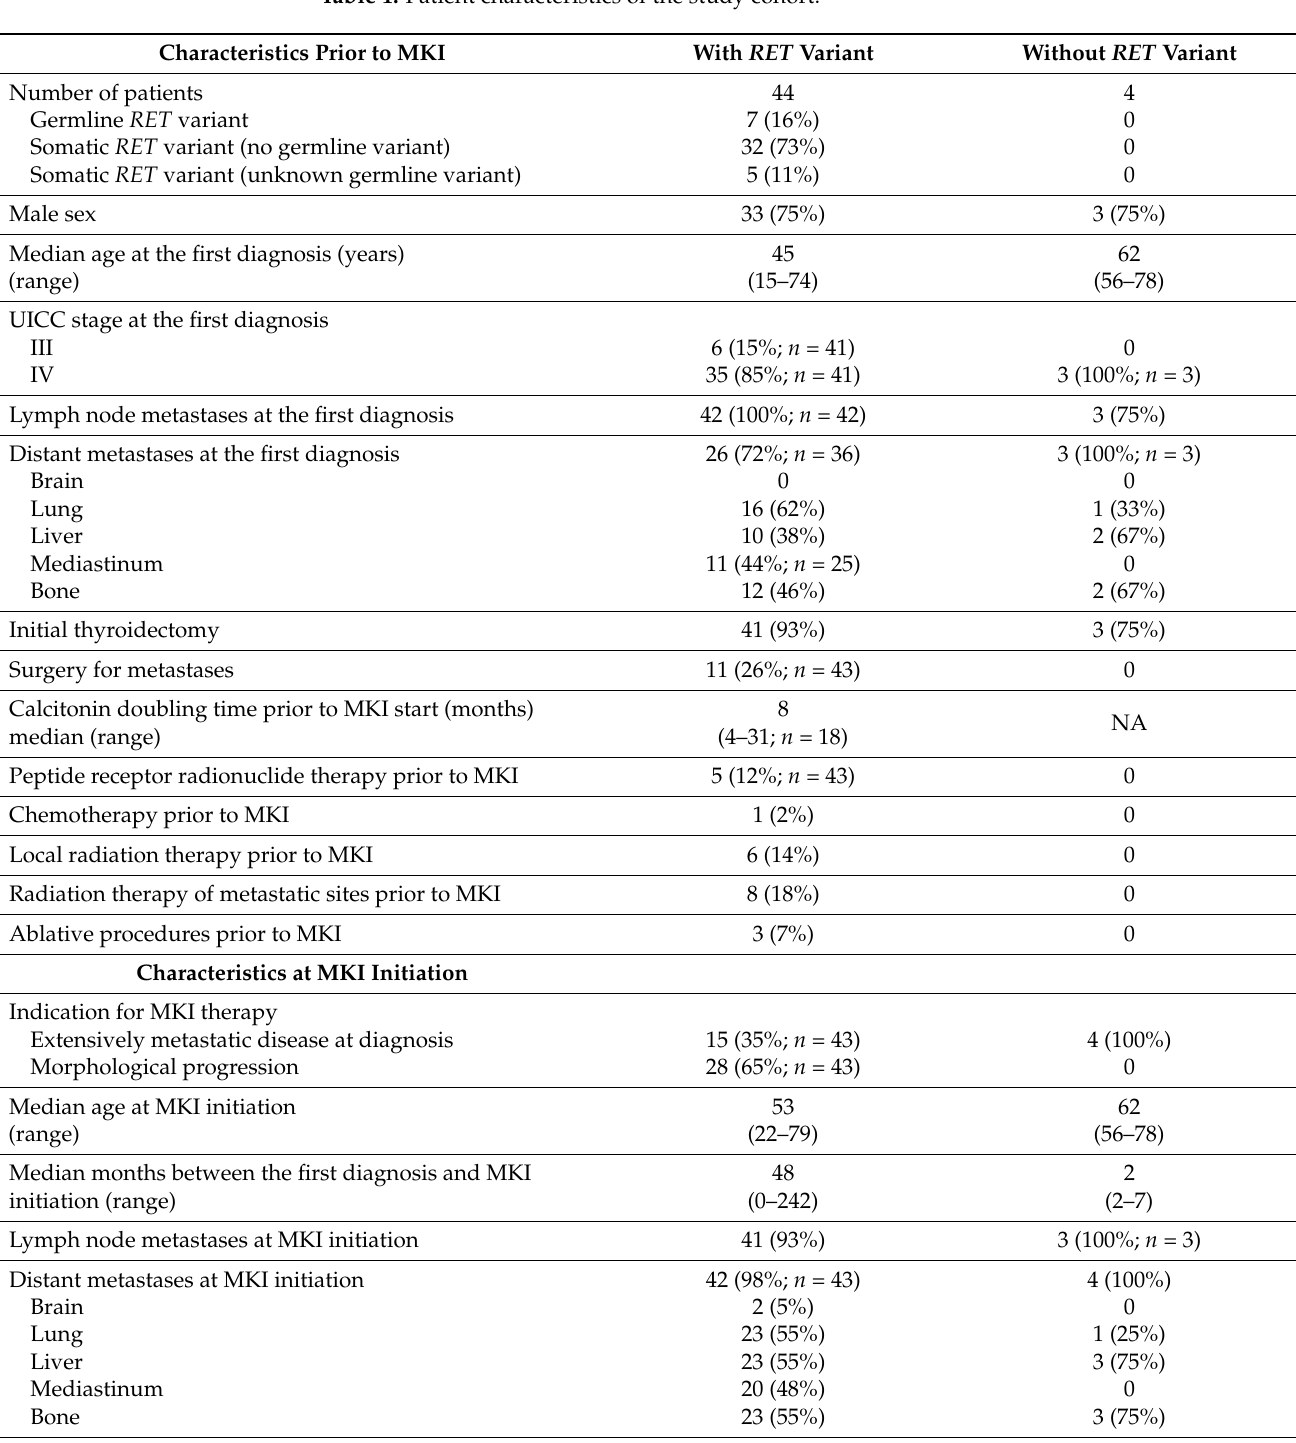
Table 1. Patient characteristics of the study